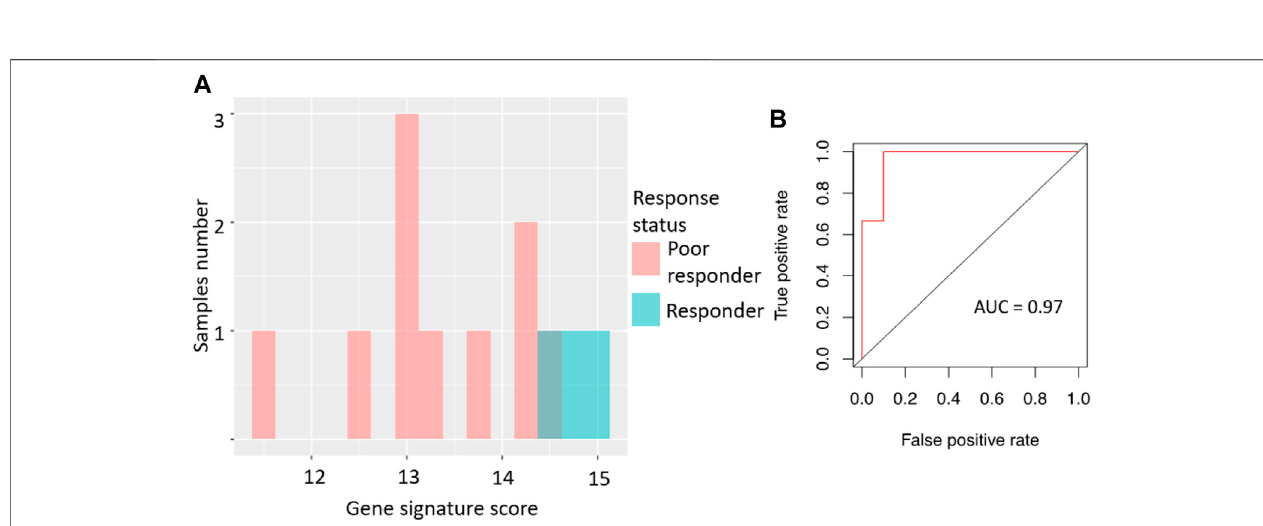
FIGURE3| PerformanceofsorafenibresponsegenesignatureinRNAseq-pro fi ledRCCset. (A) Distributionofgenesignaturescorein13RCCsamplespro fi ledby RNA sequencing. (B) ROC (receiver operating characteristic) curve for prediction of response status by gene signature score in 13 RCC samples pro fi led by RNA